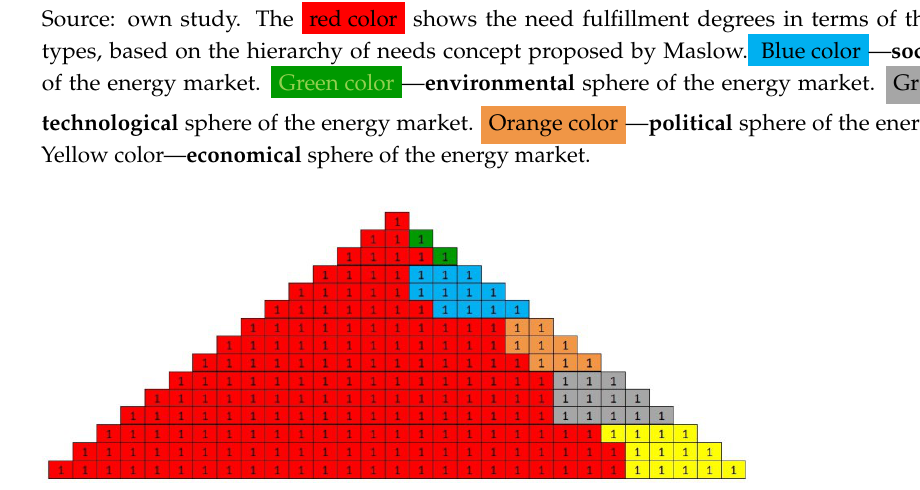
Figure 4. Need fulfillment degrees based on the expert opinions of scientists. Source: own study. Color markings as in Figure 3.